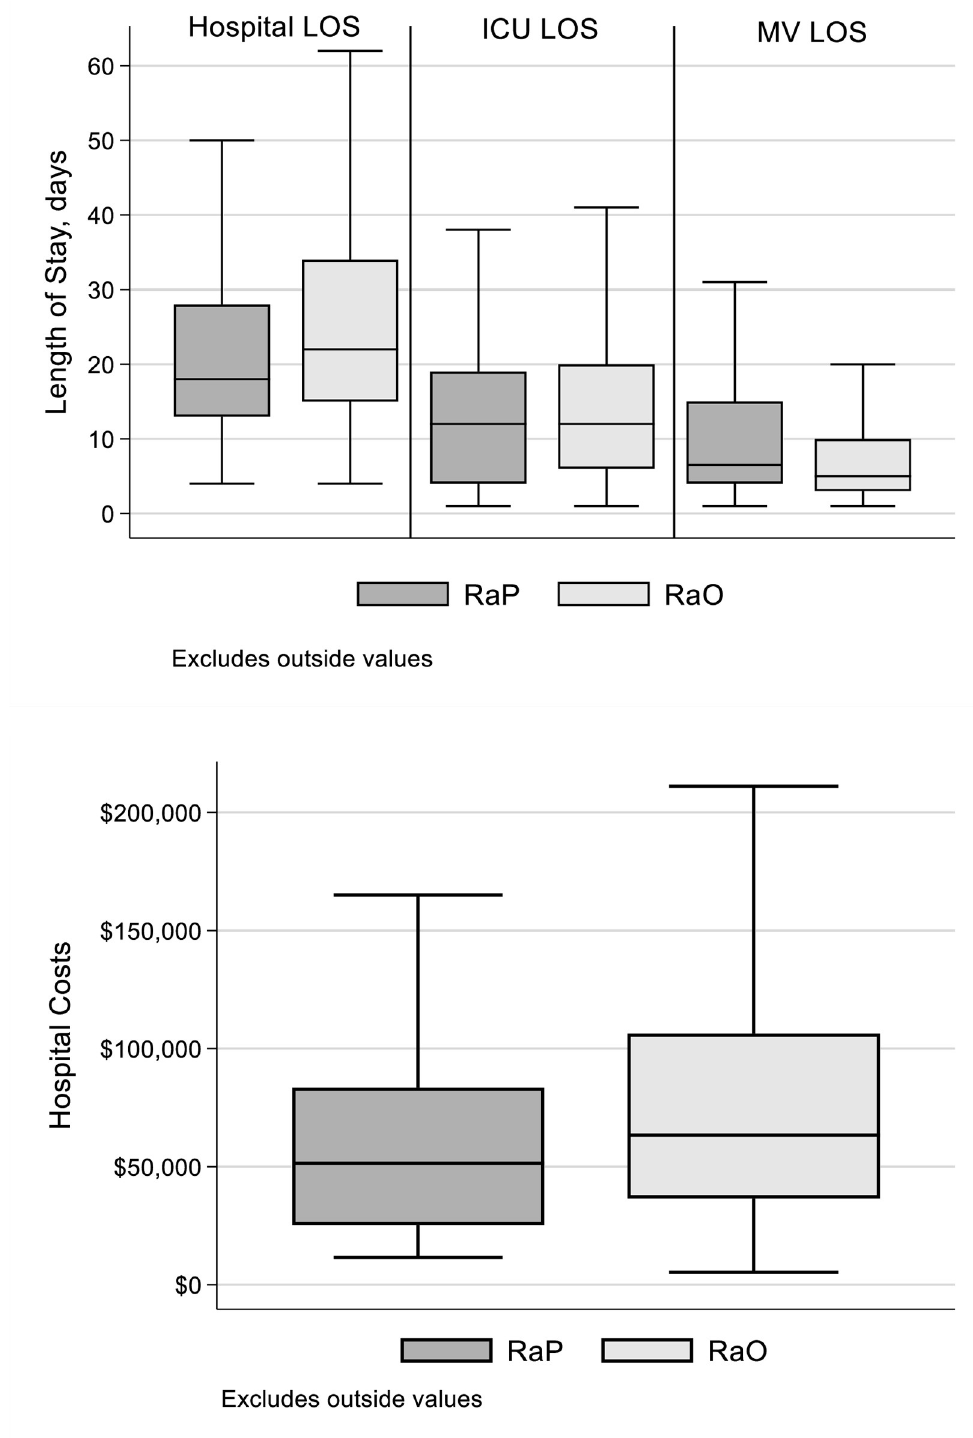
Fig 3. Resource use (A) and costs (B) associated with the index hospitalization among patients re-hospitalized due to pneumonia (RaP) or other reasons (RaO). RaP = readmission for pneumonia; RaO = readmission for another condition; LOS = length of stay; ICU = intensive care unit; MV = mechanical